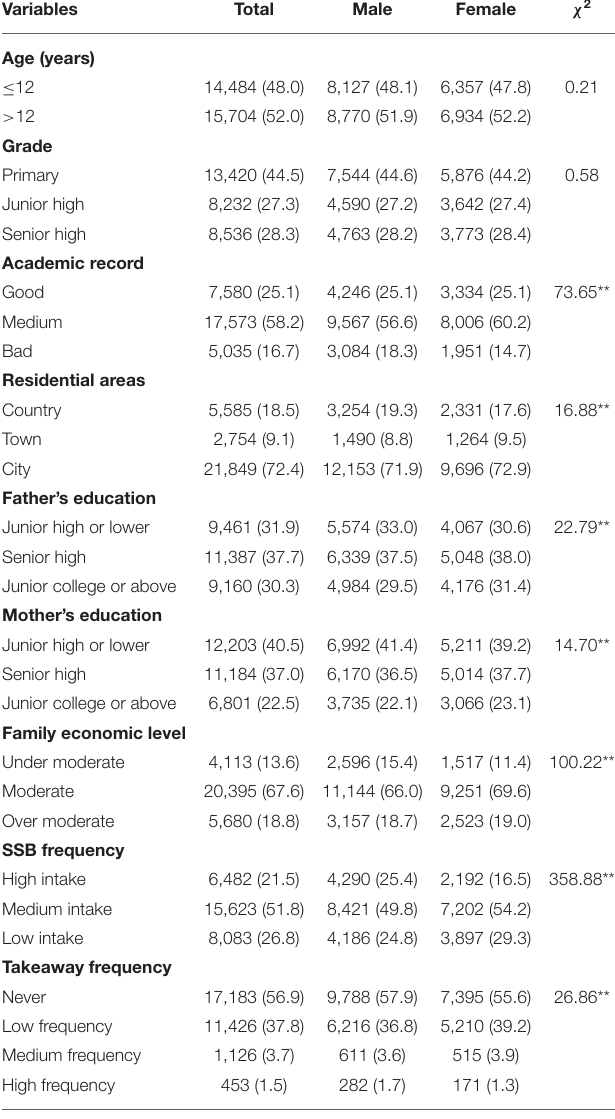
TABLE 1 | General characteristics of the samples, n (%). TABLE 2 | The gender difference of SDQ scores among the samples, n (%).